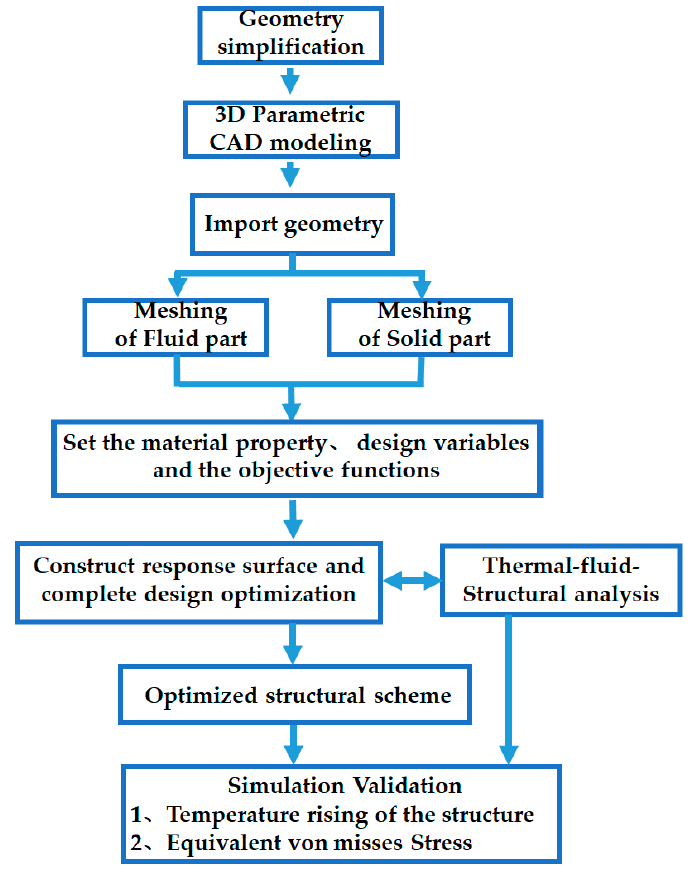
Figure 5. The basic flow chart of simulation and optimization.